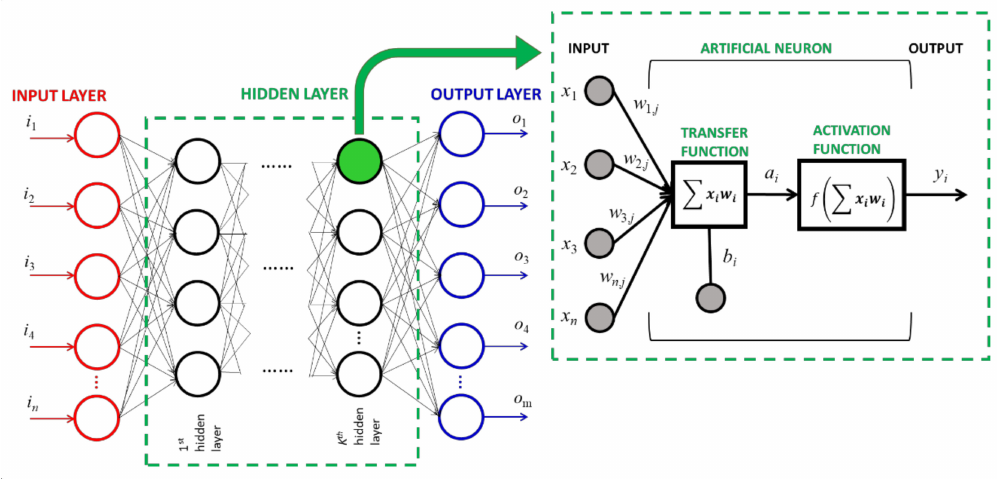
Figure 3. Illustration of artificial neural network.